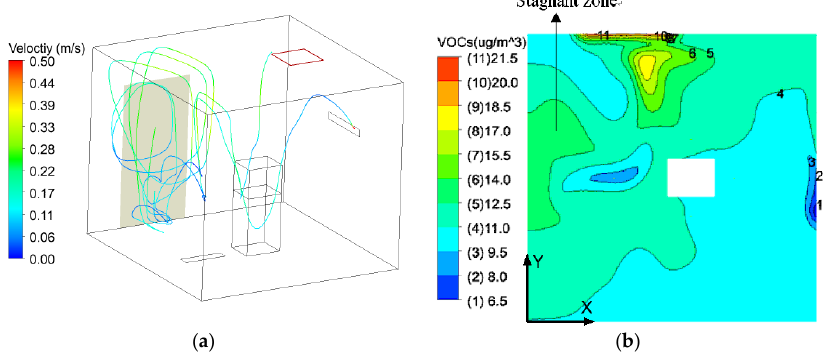
Figure 13. Air streamline and volatile organic compounds (VOCs) concentration of H = 1.5 m setting: ( a ) air path line started from VOCs source; ( b ) distribution of VOCs concentration at the Plane Z = 1.0.